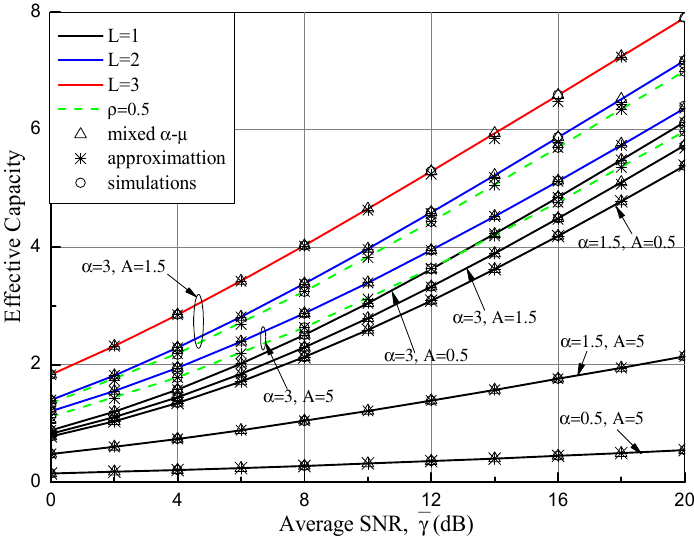
Figure 8. Effective capacity of various communication systems as a function of the average SNR ( 𝛾̅ ) over different communication conditions with n = 5 and μ = 2.